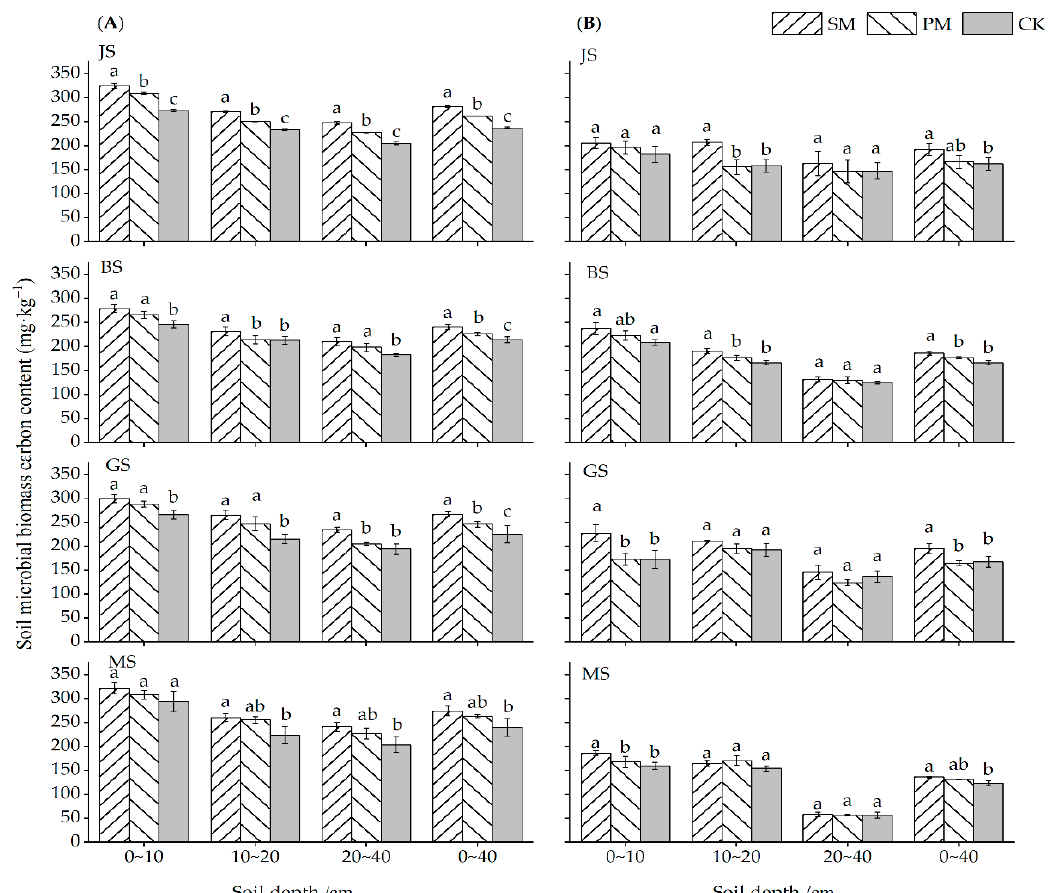
Figure 2. Soil microbial biomass contents (MBC) in different growing periods of winter wheat. ( A )